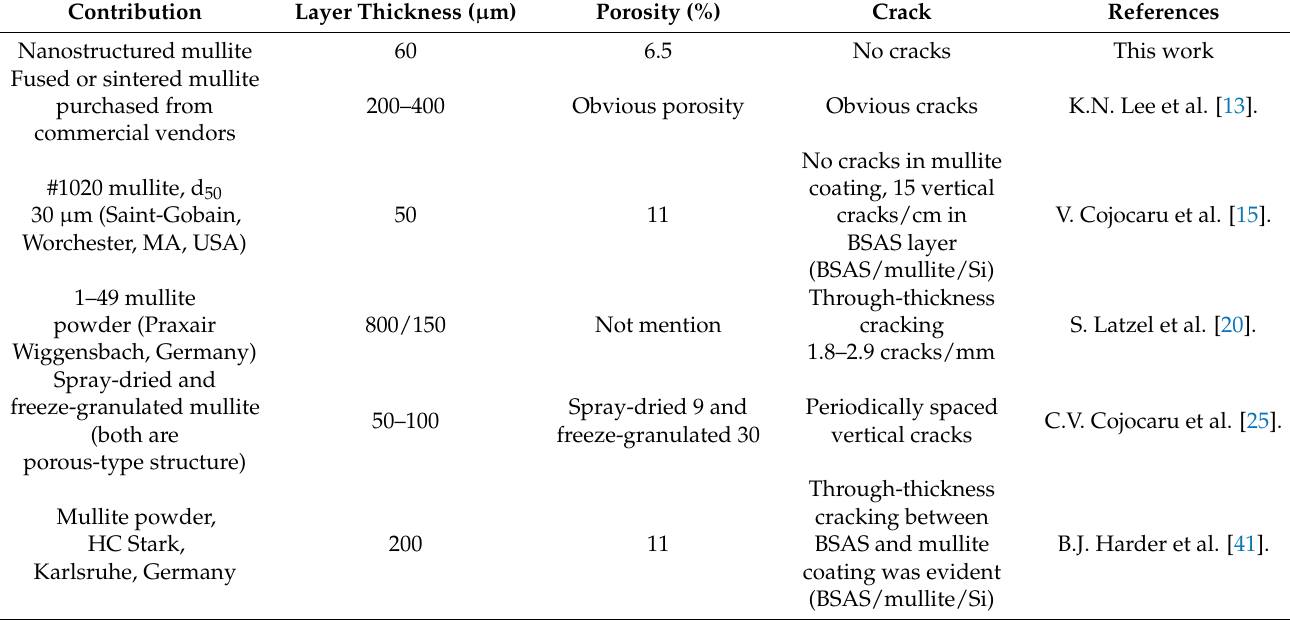
Table 6. The cracks and porosities of mullite layers by APS prepared by different